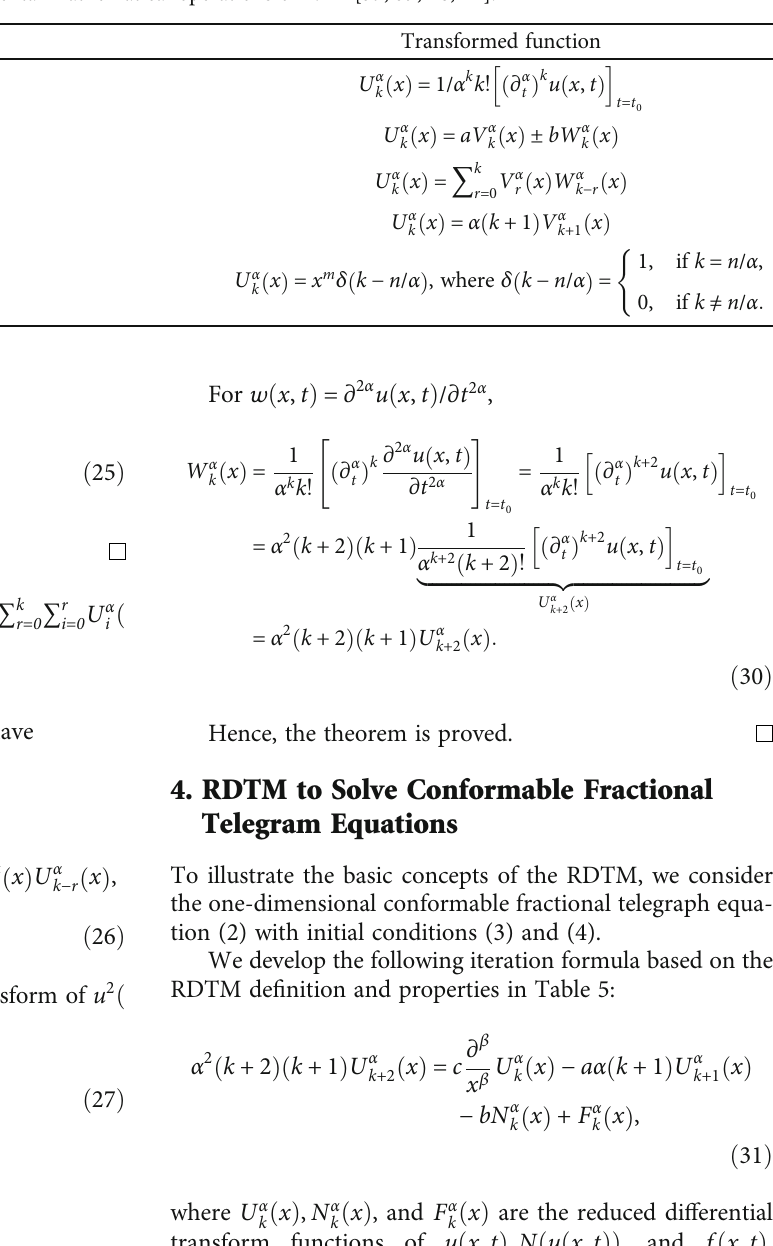
Table 5: The fundamental mathematical operations of RDT [37, 39, 40,